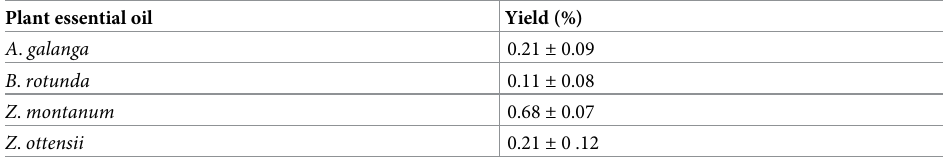
Table 1. Percent yield of essential oils from Zingiberaceae